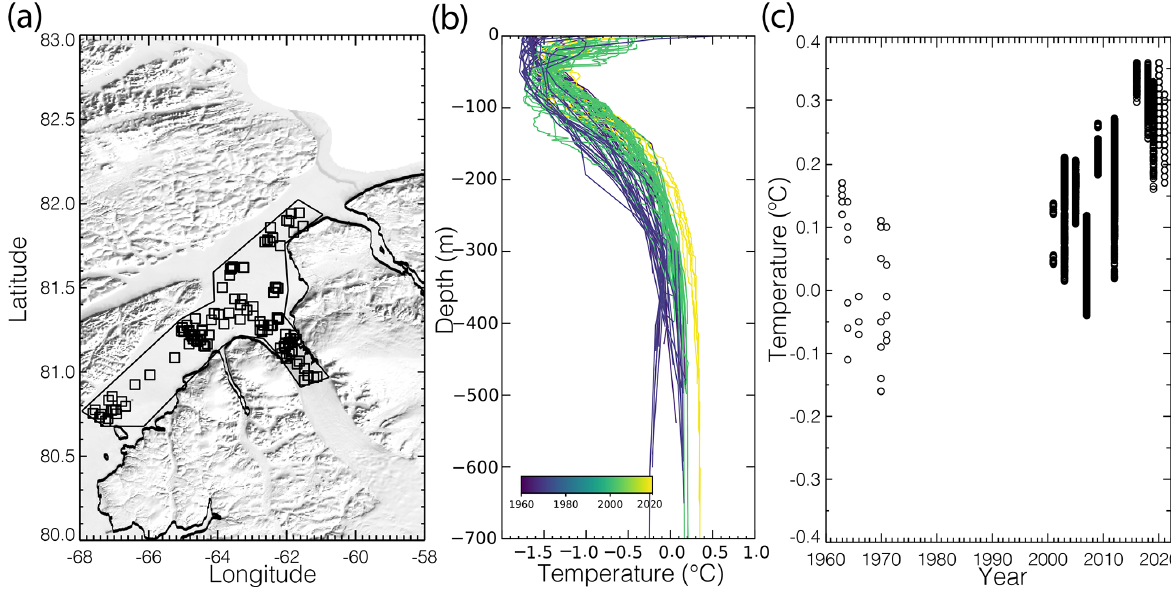
Figure 5. CTD measurements near Petermann Glacier, Greenland, with (a) CTD location from 1963–2021 with the coastline in black and the region of extraction in thin black, (b) potential temperature from CTD casts color coded by year from 1963–2021, and (c) change in temperature averaged between 350 and 450m depth from 1963 to